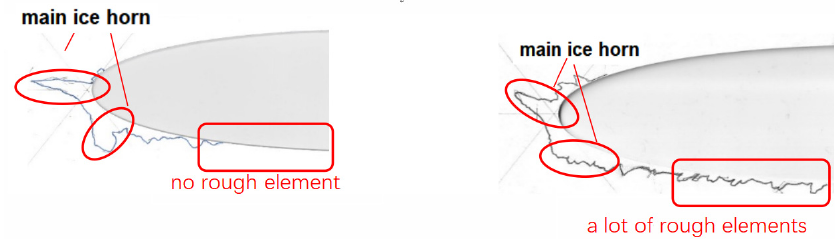
Figure 14. Ice shape of normal drop ( left ) and SLD ( right ).